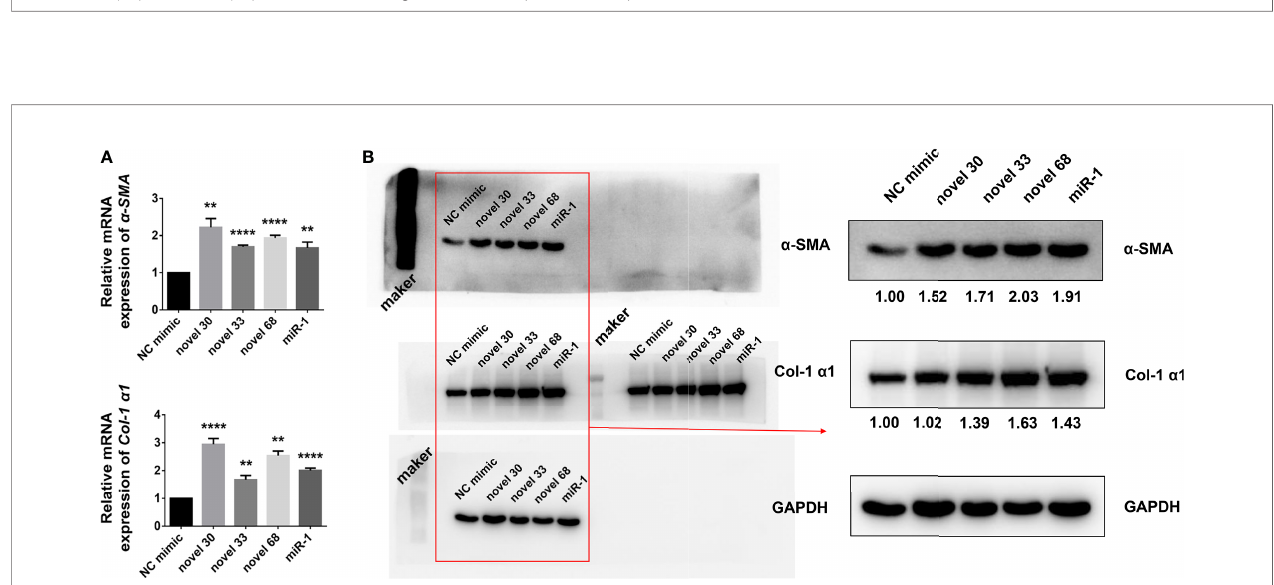
FIGURE 2 | Novel miRNA-33 mimics can activate HSCs (human hepatic stellate cells). (A) LX-2 cells were transfected with several novel miRNA mimics (novel miRNA-30, novel miRNA-33, novel miRNA-68, miR-1, miRNA-NC), cultivated for 24 h, and mRNA levels of a -SMA and Col 1 ( a 1) were measured by qPCR. (B) LX-2 cells were transfected with several novel miRNA mimics (novel miRNA-30, novel miRNA-33, novel miRNA-68, miR-1, miRNA-NC), cultivated for 48 h, and expression levels of a -SMA and Col 1 ( a 1) were measured by western blotting. Results were compared with those of the NC mimic group. The abundances of a -SMA and Col 1 ( a 1) proteins were normalized against GAPDH. Results are averaged from three independent experiments, and Student ’ s t -tests were applied to assess differences between two groups (** p < 0.001, **** p <